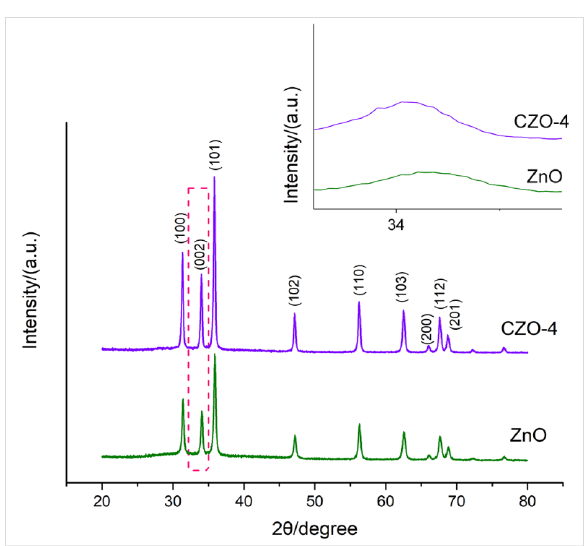
Figure 3: XRD patterns of ZnO and CZO-4 (3% Ce doping).